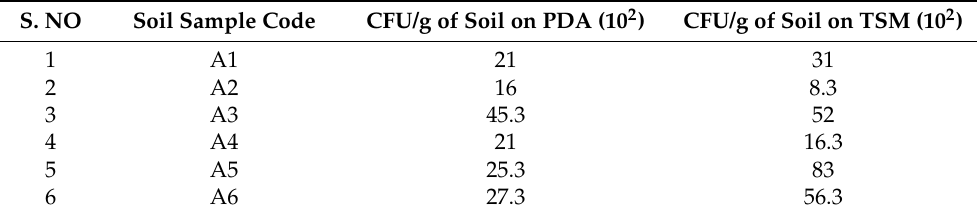
Table 1. The colony-forming units (CFU) of total fungi on PDA and Trichoderma on TSM in the soil samples collected from the Abha